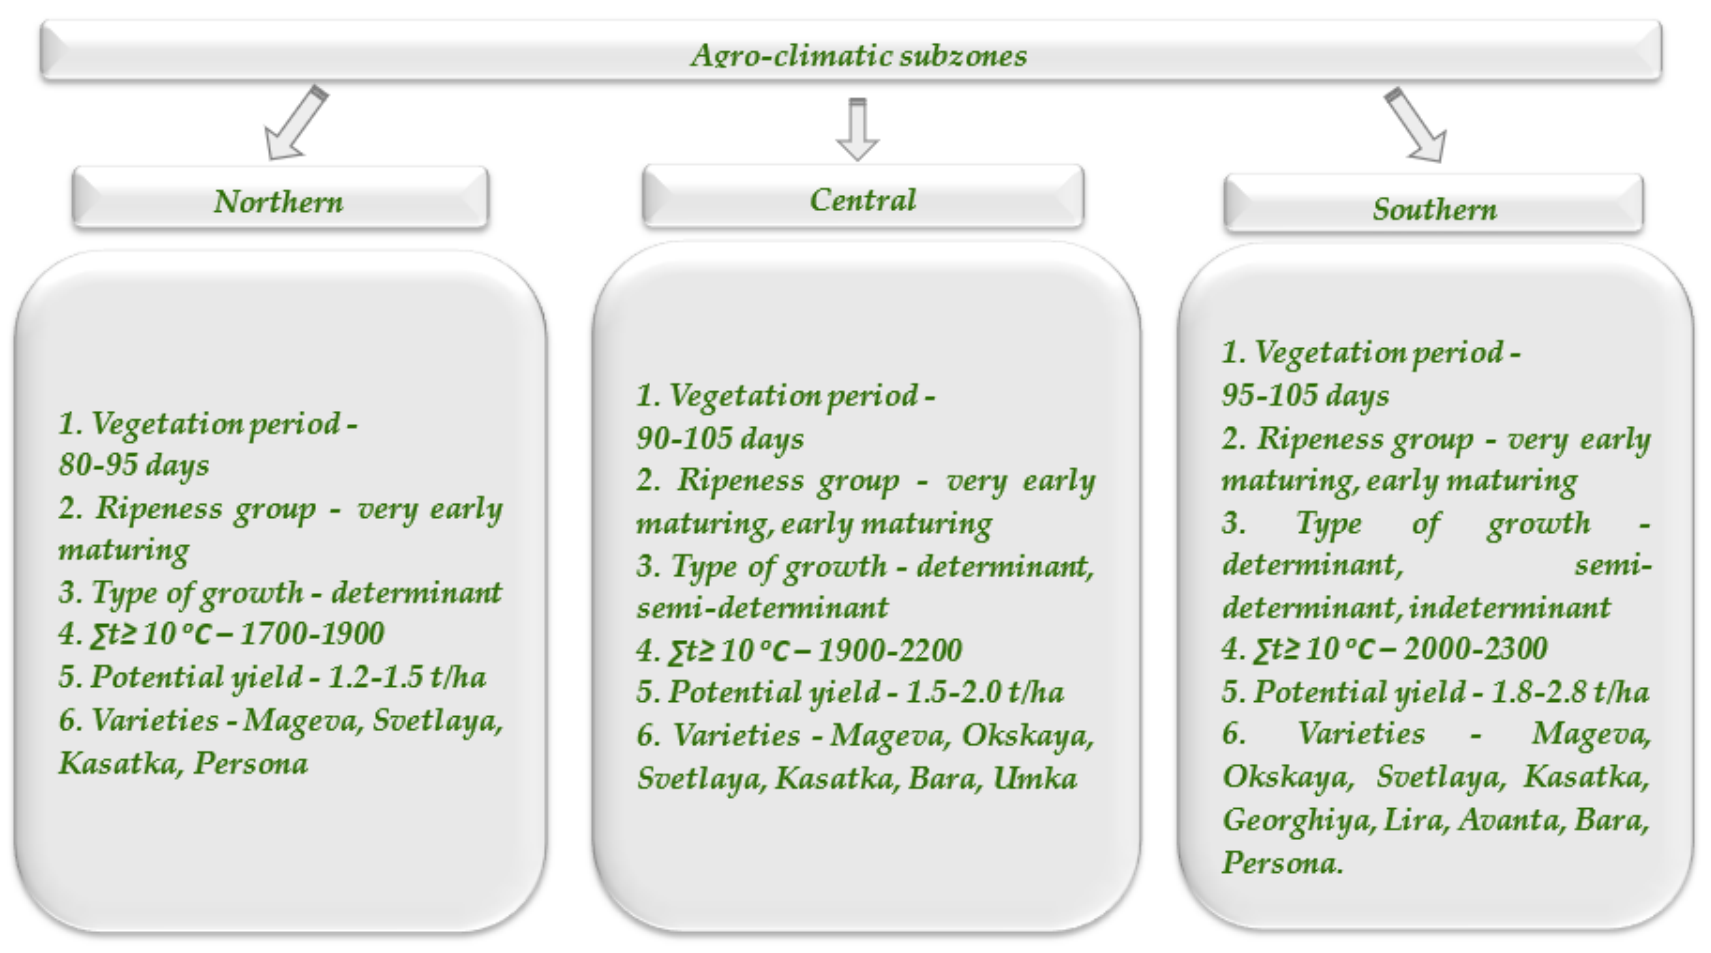
Figure 7. Models of soybean varieties recommended for cultivation depending on the agro-climatic subzone in the Central region of the Non-Chernozem zone.